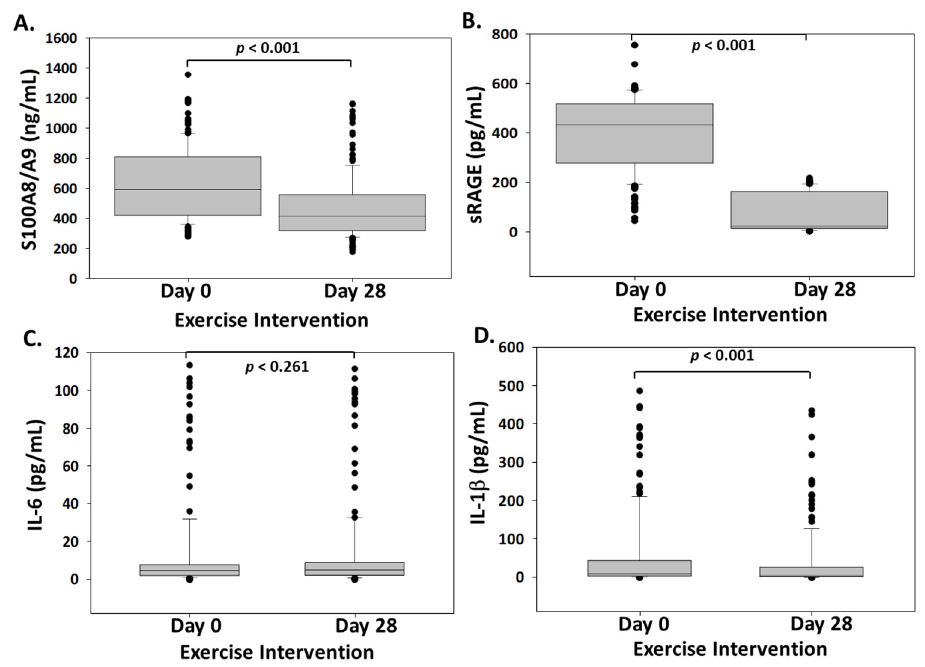
Figure 1. Boxplot chart showing the changes in plasma S100A8/A9 (ng/mL) ( A ), sRAGE (pg/mL) ( B ), IL-6 (pg/mL) ( C ), and IL-1 β (pg/mL) ( D ) presented as box plots showing median and interquartile range. n = 169.